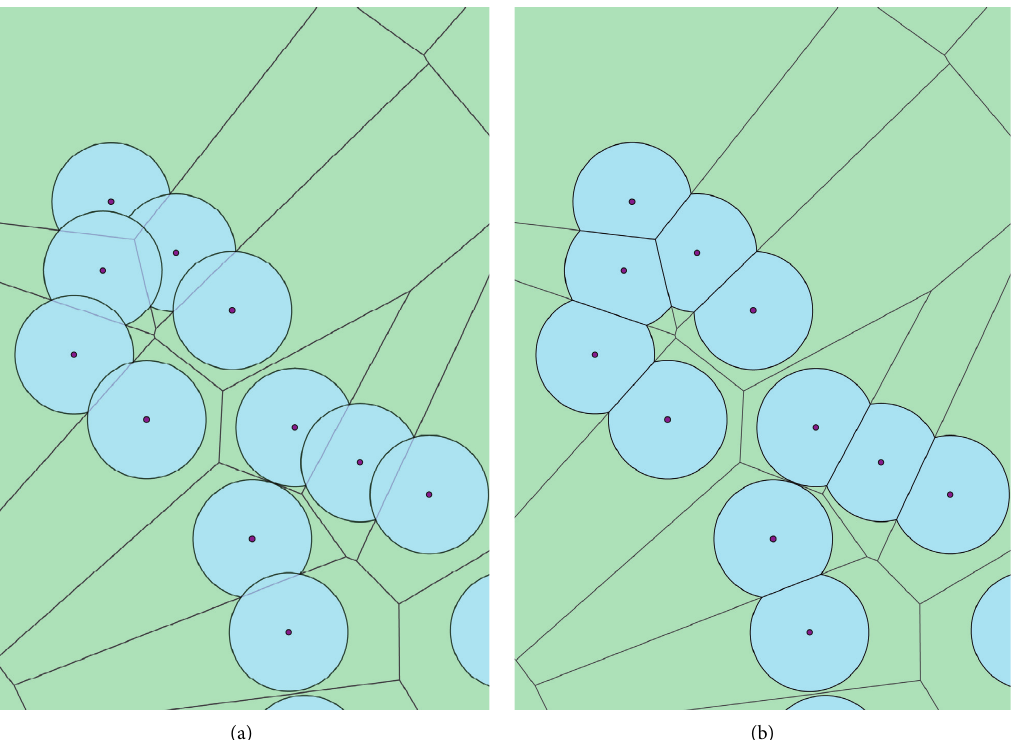
Figure 6: Intersection of circular buffer and Thiessen polygons (a) and new catchment area (b).